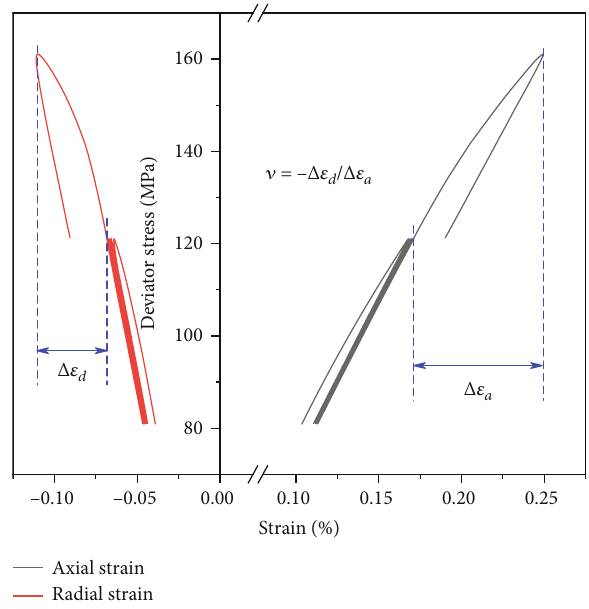
Figure 7: Calculation diagram of dynamic Poisson ’ s